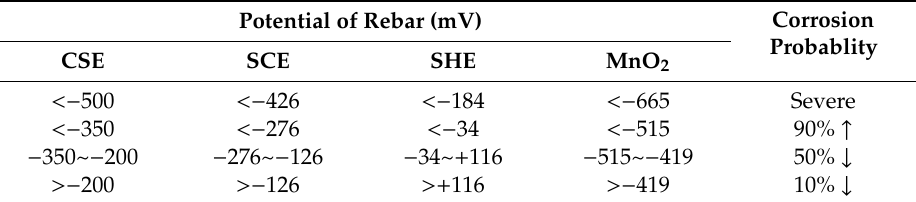
Table 4. ASTM C 876 criteria for corrosion.